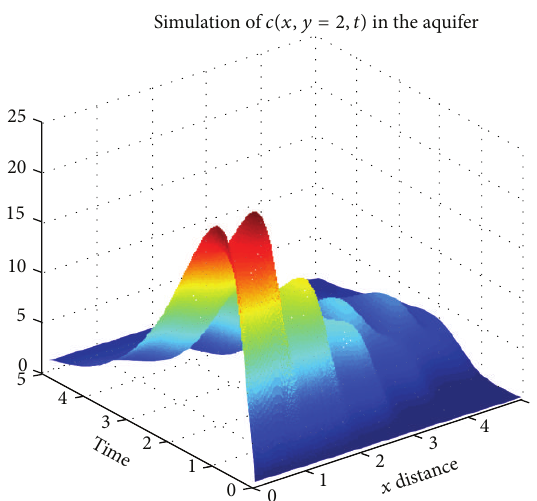
Figure1:SimulationoftheapproximatesolutionobtainedviaHDM for a fixed 𝑦 = 2